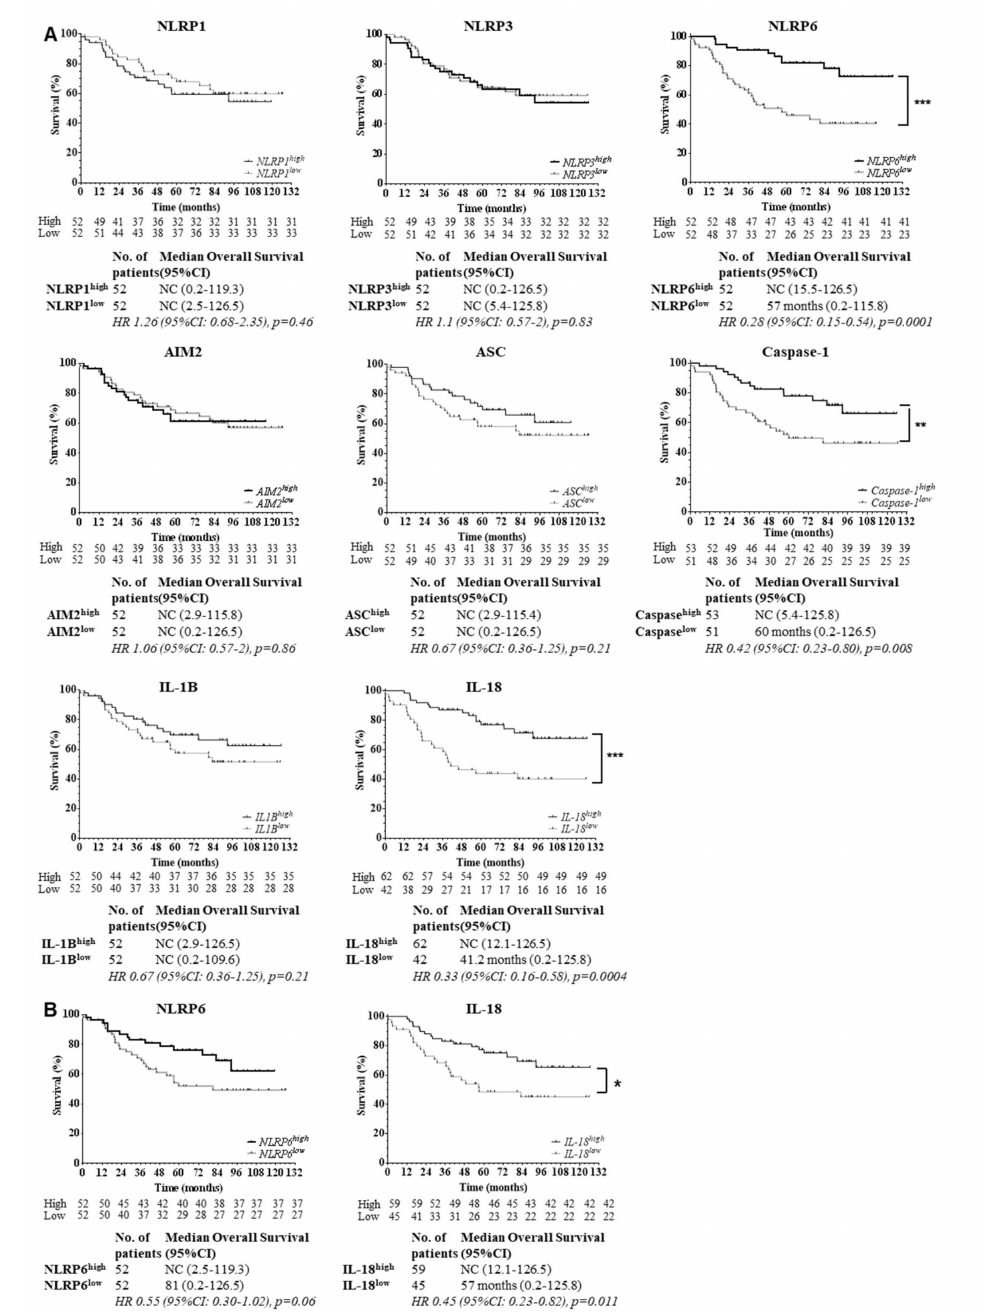
Figure 2. NLRP6 and IL-18 expressions in epithelial tumor cells are strong predictors of patients’ outcome. ( A ) NLRP6, caspase-1 and IL-18 were correlated with patients’ outcome in colorectal cancer. Survival curves of patients based on expression of inflammasome proteins in epithelial tumor cells are shown. Patients were stratified by high or low expressions according to cut-o ff s predetermined with ROC curves (NLRP6, caspase-1 and IL-18) or the median of fluorescence intensity (NLRP1, NLRP3, AIM2, ASC, IL-1B). Censored data are indicated by tick marks. Data for any patients who were not known to have died at the time of the analysis were censored at the last recorded date that the patient was known to be alive. 95%CI: 95% confidence interval; HR: Hazard Ratio. A log-rank test stratified according to protein expressions was used. NC: could not be calculated. ( B ) Stromal protein